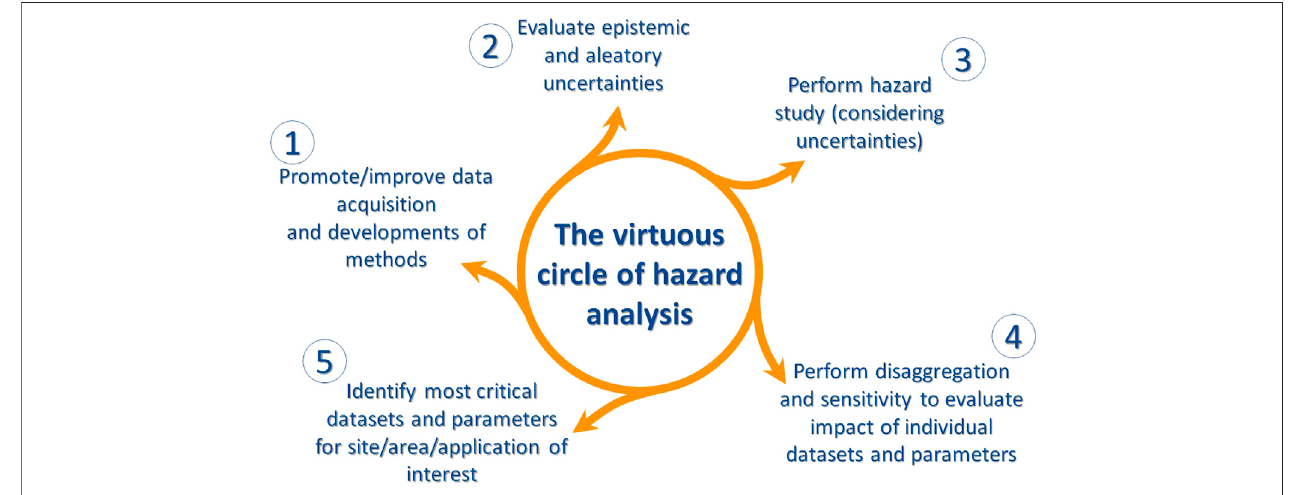
FIGURE 14 | The virtuous circle of hazard